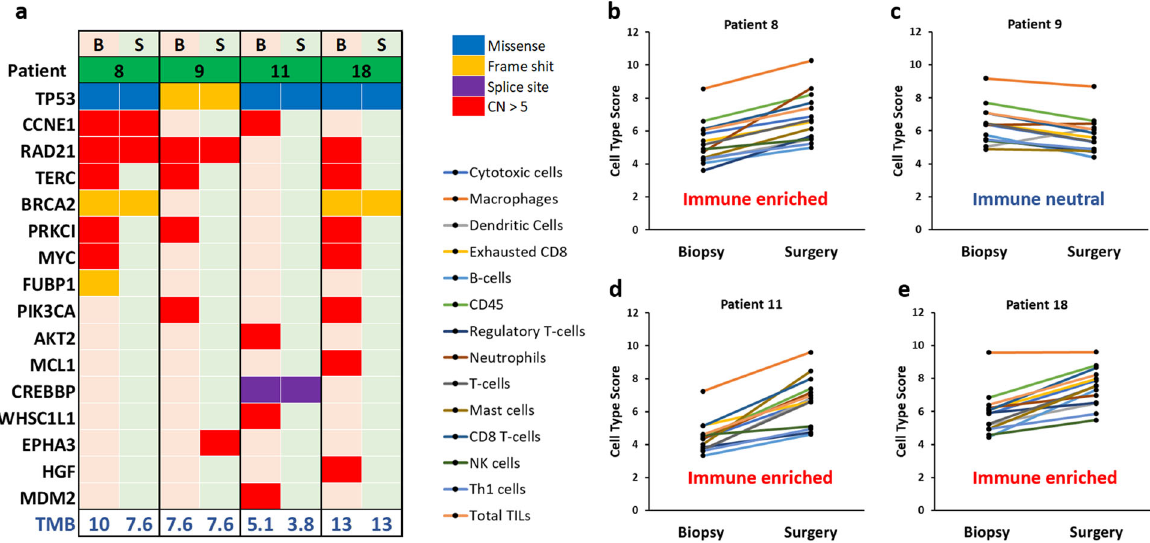
Fig. 6 Correlation of genomic alterations with increased immune cell in fi ltration in EOC surgery samples. a Mutation plot of paired biopsy – surgery samples that coincided with paired biopsy – surgery samples used for immune pro fi ling by nCounter gene expression analysis. B biopsy, S surgery. Gene alterations are annotated according to the color panel at the left side of the image. b – e Line graphs representing the abundance of immune cell populations in paired biopsy – surgery samples of patients 8 ( b ), 9 ( c ), 11 ( d ), and 18 ( e ) before and after NACT. TMB tumor mutational